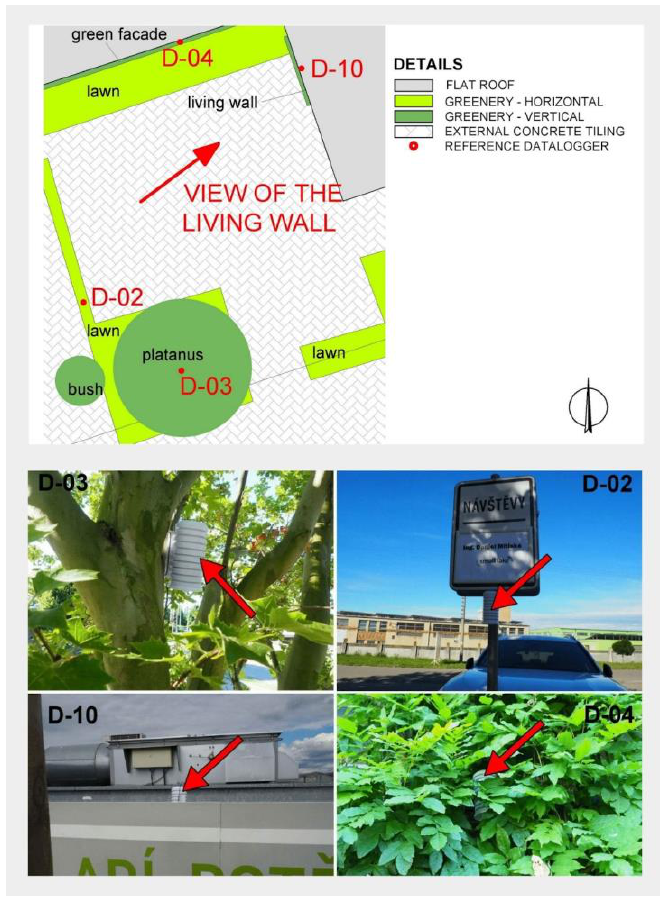
Figure 3. Reference dataloggers (4 in total) were deployed in different conditions in the vicinity of the LW under study. Given the surrounding conditions, two sites were selected that are considered natural — the crown of the Platanus occidentalis (D-03) and a green facade formed by Wisteria sp. In addition to these, the two locations where the worst results were expected were selected — a road sign (D-02) and the roof of the building (behind the attic) on which the investigated LW is located (D-10). All reference dataloggers are located within 10 m from the LW.